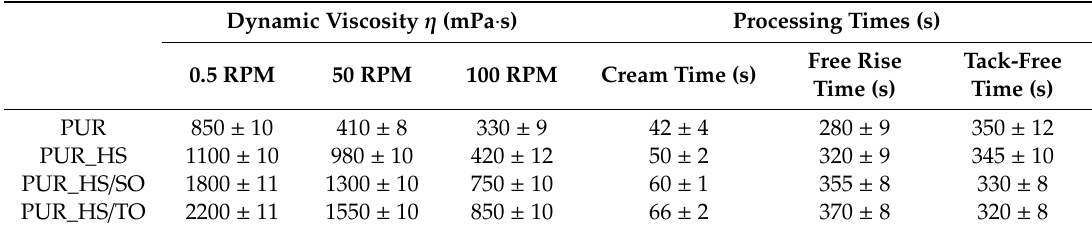
Figure 3. Topography and particle size of ( a – c )—HS filler, ( d – f )—HS / SO filler and ( g – i )—HS / TO filler. Table 3. The impact of HS fillers on viscosity and processing times of PUR